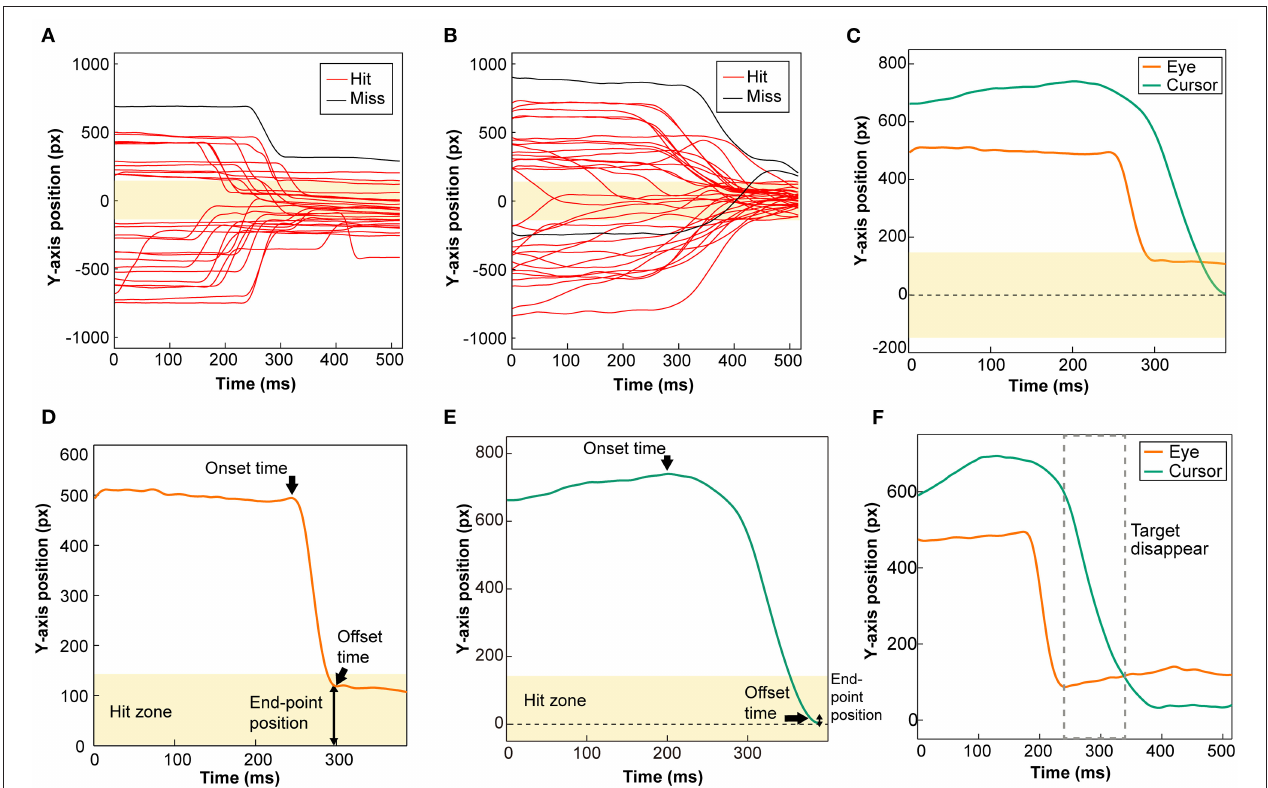
FIGURE 2 | Typical cursor and eye trajectories during the task and analytic parameters of the cursor and eye movement. (A) All trial trajectories of eye movements to the vertical axis on the display at the target speed 3,000 pixels/s. (B) All trial trajectories of the cursor movement to the vertical axis on the display at the target speed 3,000 pixels/s. Red and black lines indicate Hit and Miss trials, respectively. (C) Orange and green lines show a single trajectory of the eye and cursor movement, respectively. (D) A single trajectory of eye movement along the vertical axis was used to analyze three parameters (SEA onset time, offset time, and end-point position). (E) A single trajectory of cursor movement along the vertical axis was used to analyze three parameters (RCA onset time, offset time, and end-point position). In all figures, the yellow zone indicates the zone in which the cursor hits the target (Hit zone), and the zero value is the Y-axis position of the target. (F) Orange and green lines show a single trajectory of the eye and cursor movement at the NoFB condition, respectively. The gray dotted line indicates the time when the target